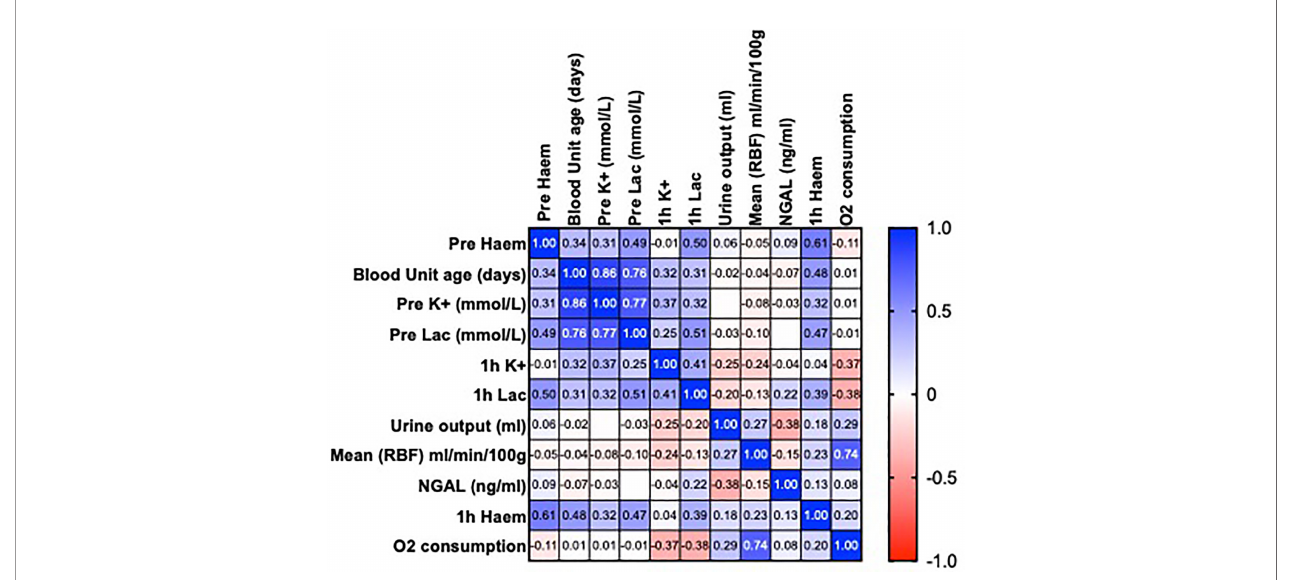
FIGURE 1 | Heatmap showing Pearson ’ s correlation matrix to examine the associations of the age of packed red blood cells and levels of free heme on perfusion parameters before and after 1h of normothermic machine perfusion (NMP). Values are